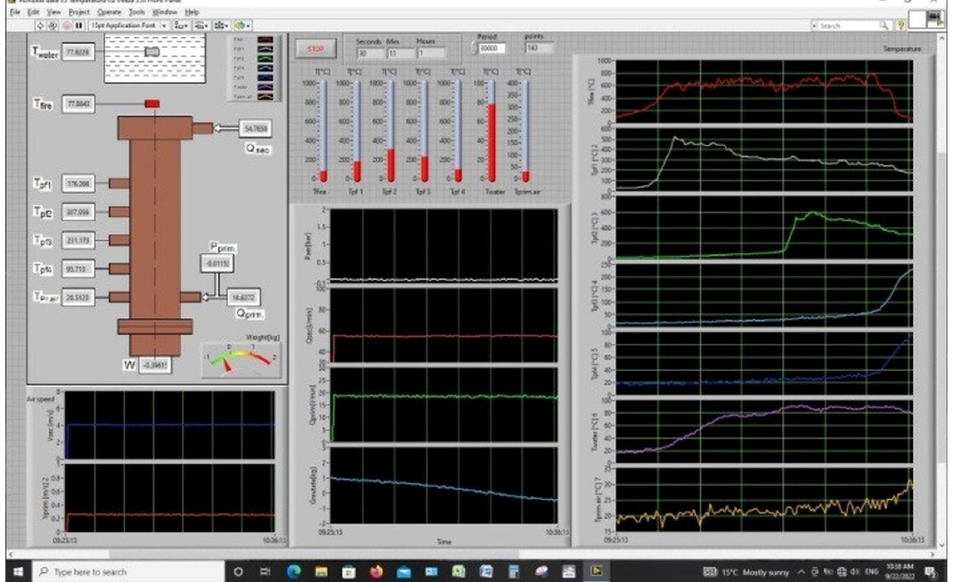
Figure 6. Graphical interface developed in LabView.